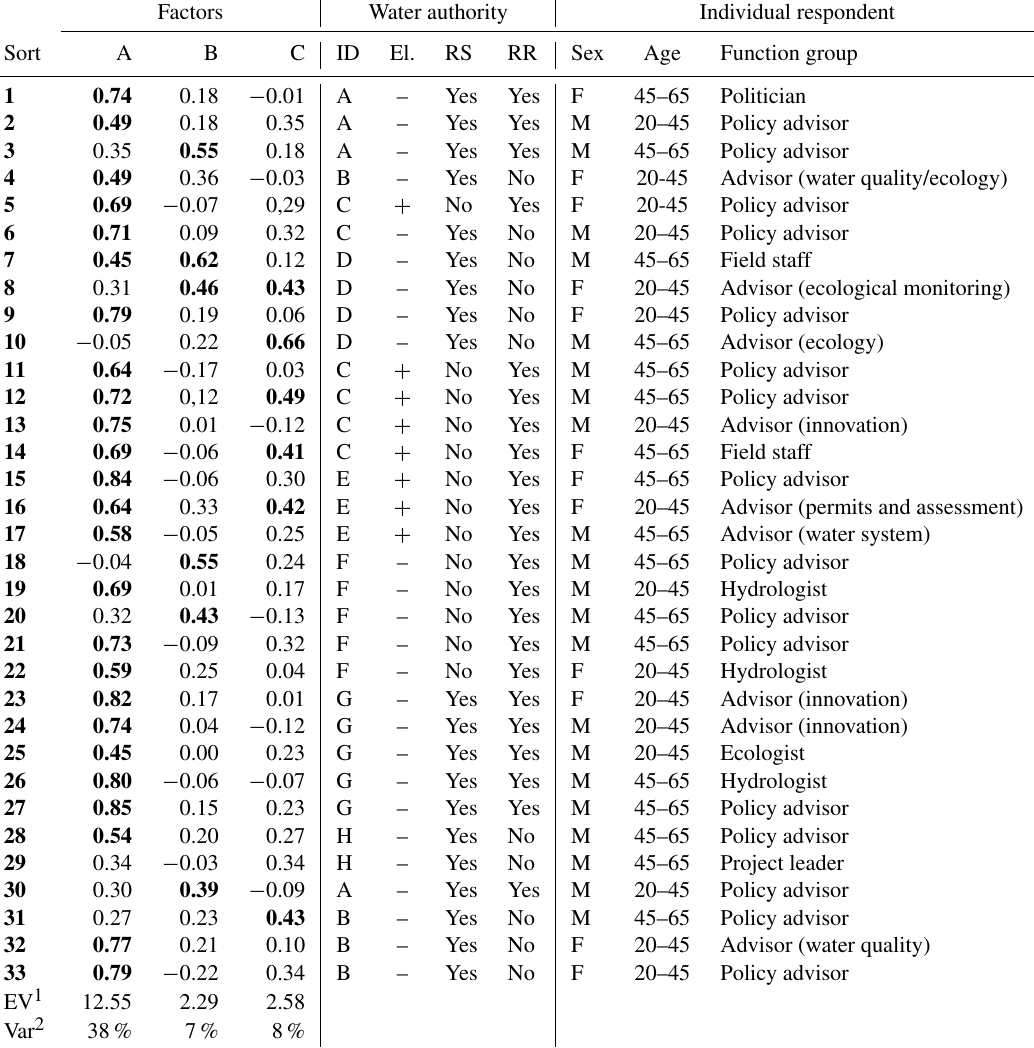
Table 2. Final factor loadings after rotation. Sorts in bold indicate that a person’s loading exceeds the significant factor loading (SFL) and a person’s viewpoint thus resembles Viewpoint A, B or C. Also included are characteristics of respondents: water authority (Identification (ID), elevation above sea level (El), located in Randstad (RS) and recently reformed (since 2005)) and individual characteristics (sex, age and function